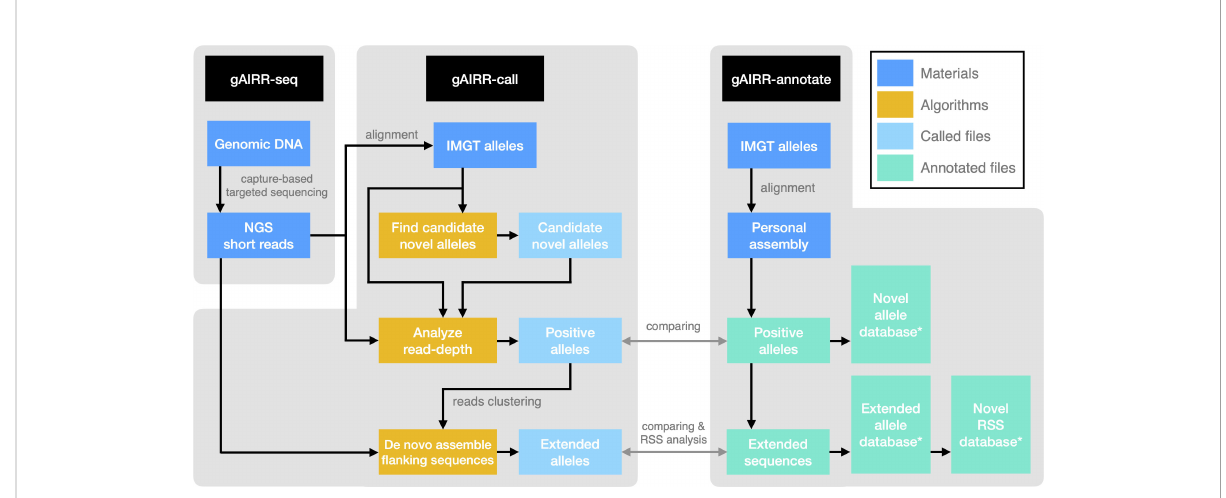
FIGURE 1 The gAIRR Suite pipelines. The gray arrows show the veri fi cation methods between the two pipelines when both gAIRR-seq reads and personal assembly are available. (Section 2.5). *: These database can also be generated by gAIRRseq +